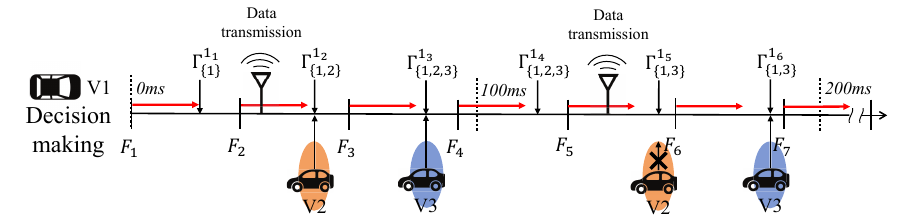
Figure 7. Example of the considered data communication system and real-time data fusion process. V1 can receive several data within the predetermined cycle (100ms), and a decision-making algorithm updates the fused output in